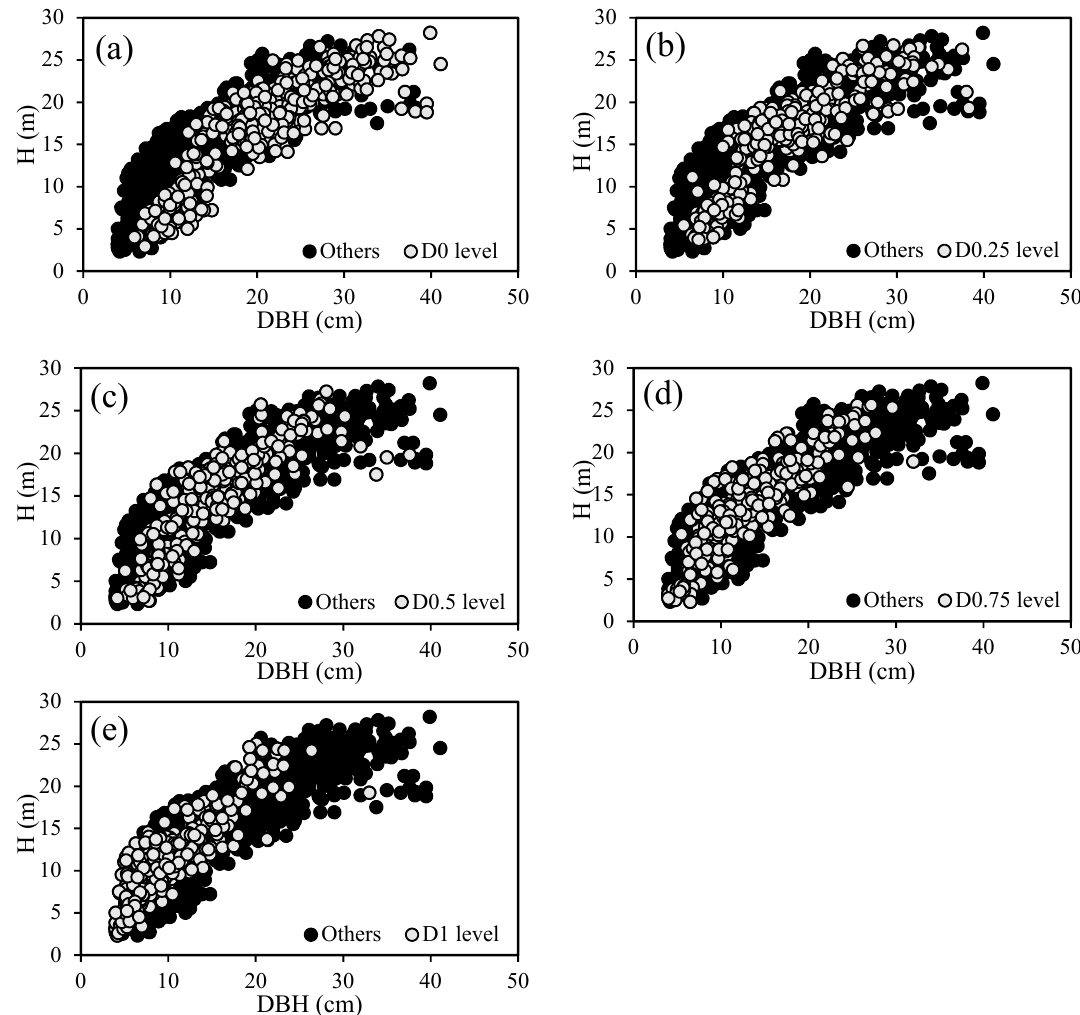
Figure 2. The plotting of H ‒ D relationships for D 0 , D 0.25 , D 0.5 , D 0.75 and D 1 competition levels (Figure 2 a – e , respectively). The white symbols are trees of D i level, and black symbols are trees of the other levels.